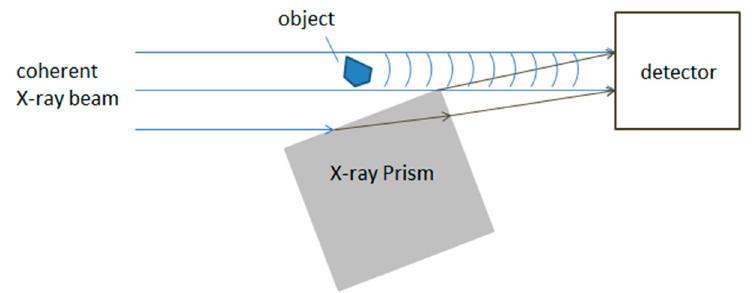
Figure 4. Sketch of the prism interferometer.